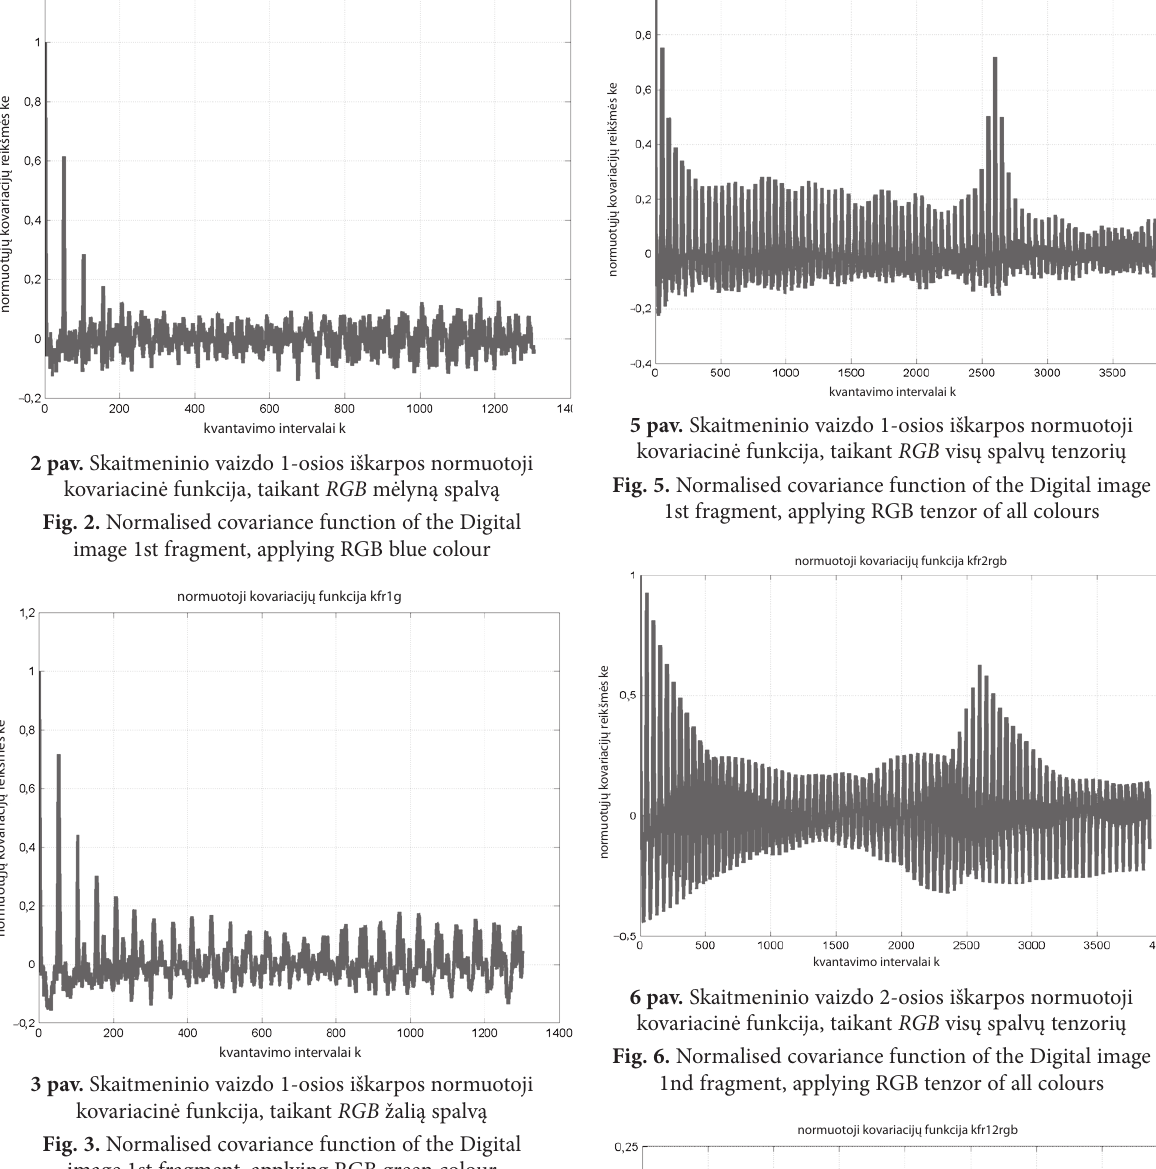
Fig. 3. Normalised covariance function of the Digital image 1st fragment, applying RGB green colour